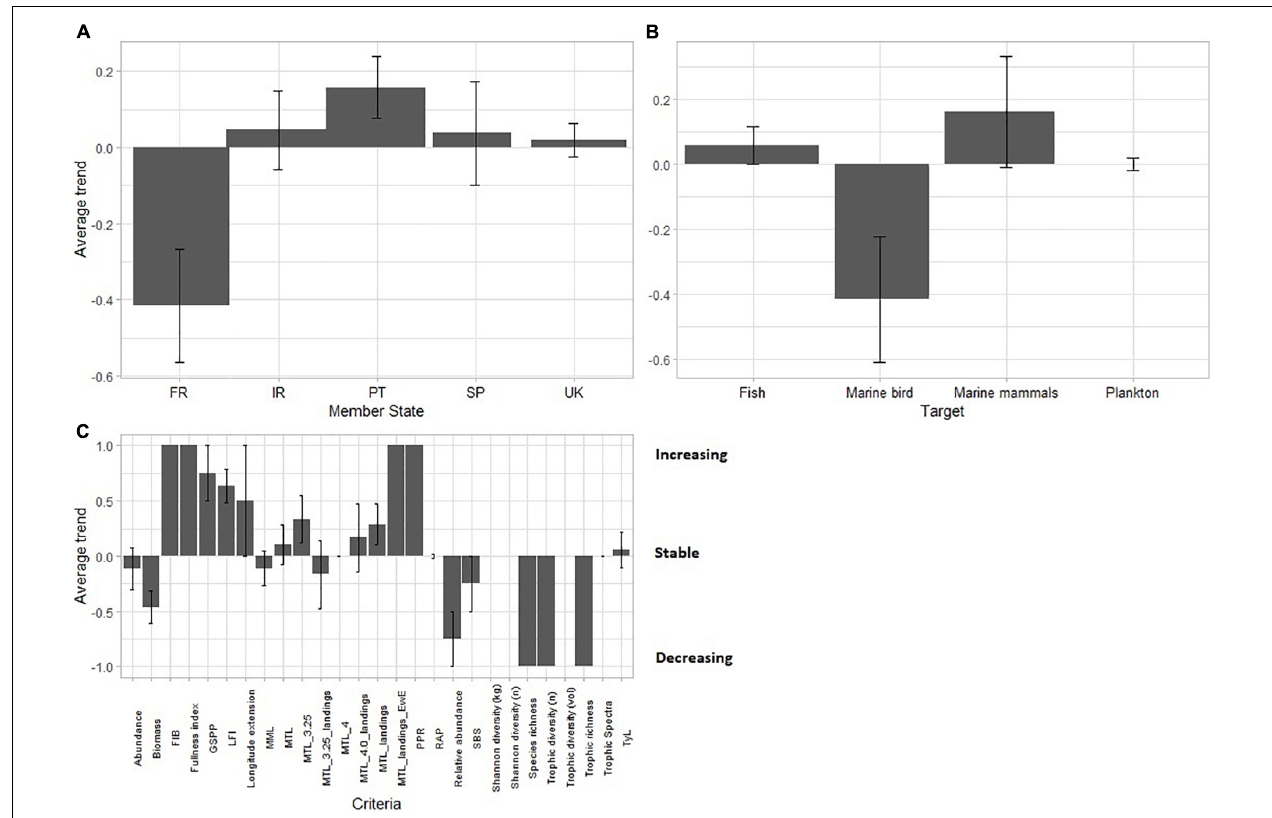
FIGURE 3 | Average assessment trend for food web criteria per MS (A) , ecosystem element (B) and criteria (C) resulting from the GLM analysis applied to Descriptor 4—Food webs data in the NE Atlantic.